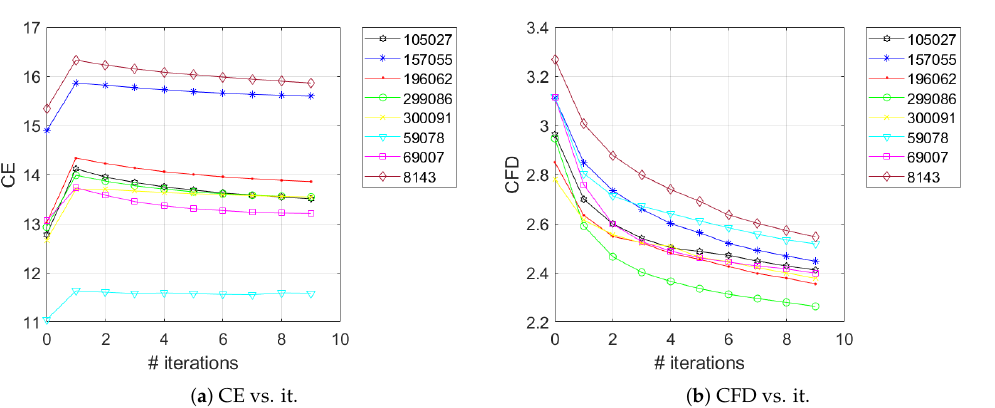
Figure 8. The evolution of color entropy ( a ) and color fractal dimension ( b ) as a function of the number of iterations of the Gaussian filter, for the eight images in Figure 2.